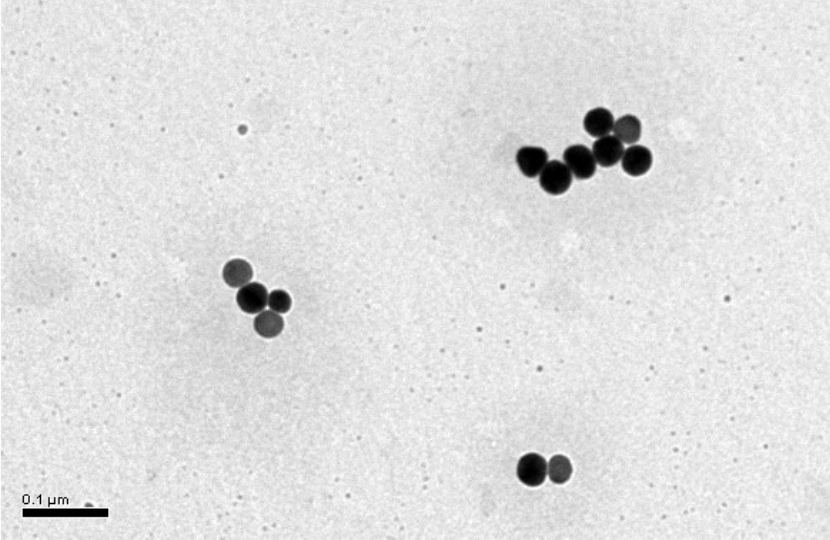
Figure 1. Transmission electron microscopy image of GNPs at a magnification of 100,000, where the scalebar denotes 100 nm. The average diameter of the GNPs is 27.9±9.1nm.